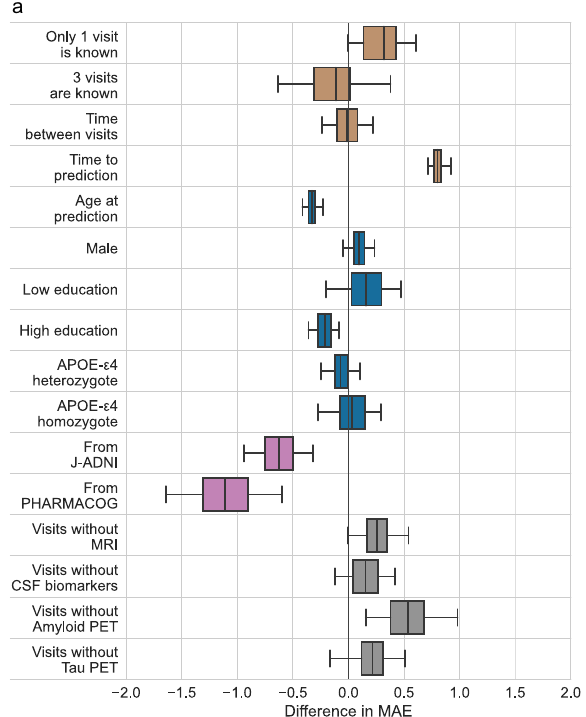
Fig.3|Changesinforecastabsoluteerrorsdependingoncovariates. Resultsare presented for the forecast of ADAS-Cog13 with the AD Course Map. a Changes due to forecast design (4 top rows, in brown), genetic and sociodemographic characteristics of the participant (rows 5 – 10, in blue), the cohort of the partici- pant (rows 11 and12,in pink), andmissing data (rows 13 to 16, in gray). b Changes due to A(myloid)/T(au)/N(eurodegeneration)/C(linical) status of the participant, grouped in: Alzheimer ’ s continuum at the top (8 top rows, in green), possible Alzheimer ’ s disease and concomitant non-Alzheimer ’ s pathologic change in between (row 9, in orange), and suspected non-Alzheimer ’ s pathophysiology